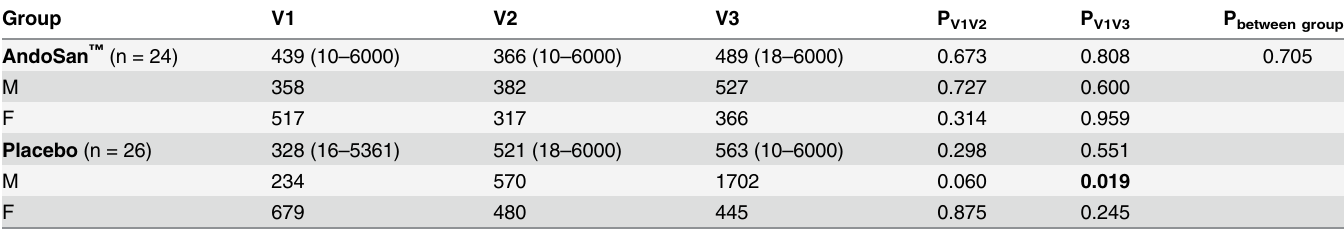
Table 7. Fecal test in the 50 UC patients.